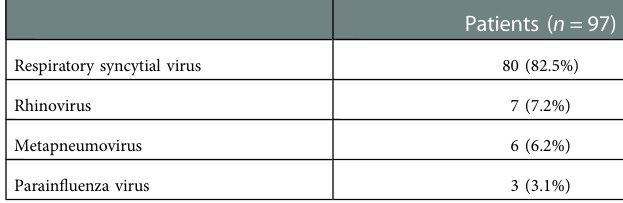
TABLE 3 Identi fi ed microorganisms causing bronchiolitis.